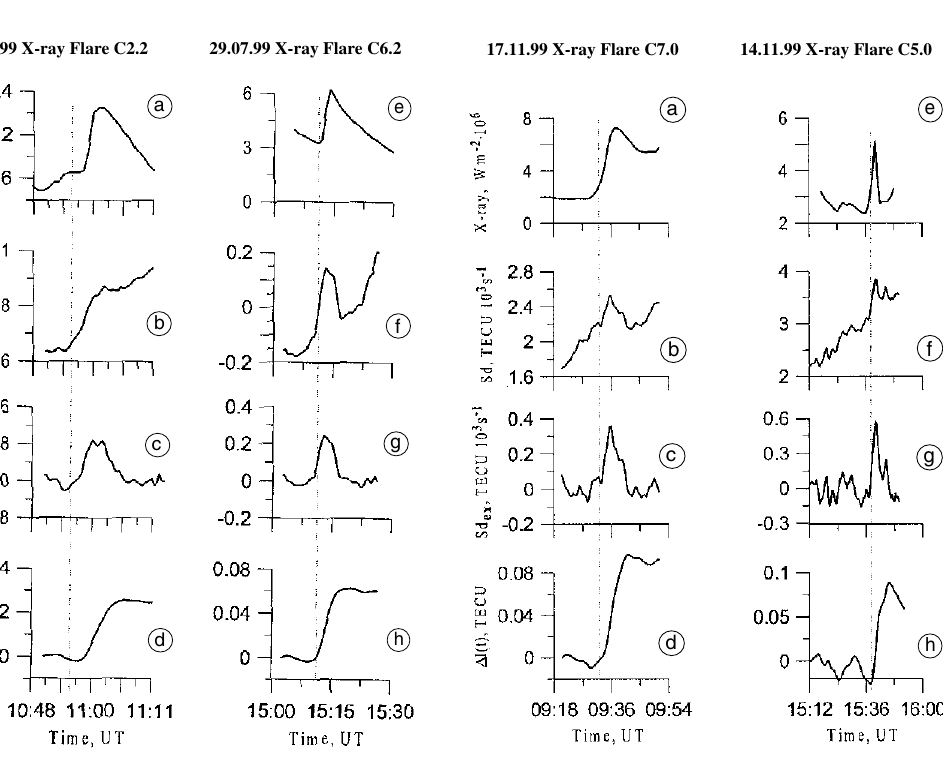
Fig. 2a-h . Faint solar flare July 29, 1999 (C2.2, 11:00 UT) (a-d); soft X-ray emission flux (GOES- 10) in the range 1-8 Å (a); normalized result of a coherent summation Sd of the time derivatives of the TEC variations for all LOS (b); the same curve (b), upon subtracting the trend determined as a polynomial of degree 3 on the time interval 10:48- 11:11 UT; mean integral increment of TEC (d). Analogous dependencies for faint solar flare July 29, 1999 (C6.2/SN, 15:14 UT, N25E53) on panels (e-h).